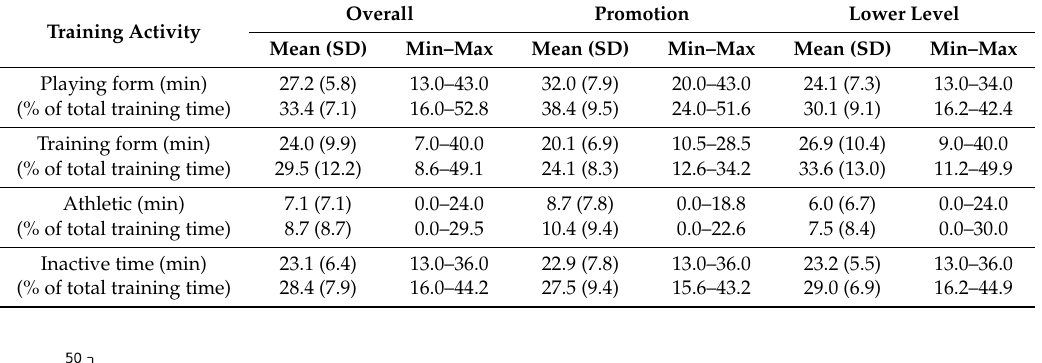
Table 2. Mean duration of training activities during training sessions. Data presented as means with standard deviation and minimum and maximum.